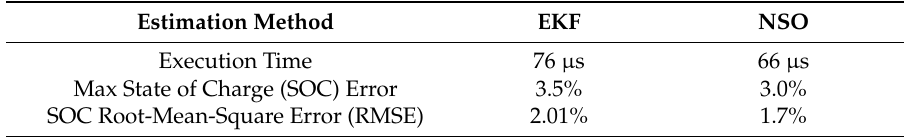
Table 2. Comparison of the extended Kalman filter (EKF) and the nonlinear state observer (NSO). Estimation Method